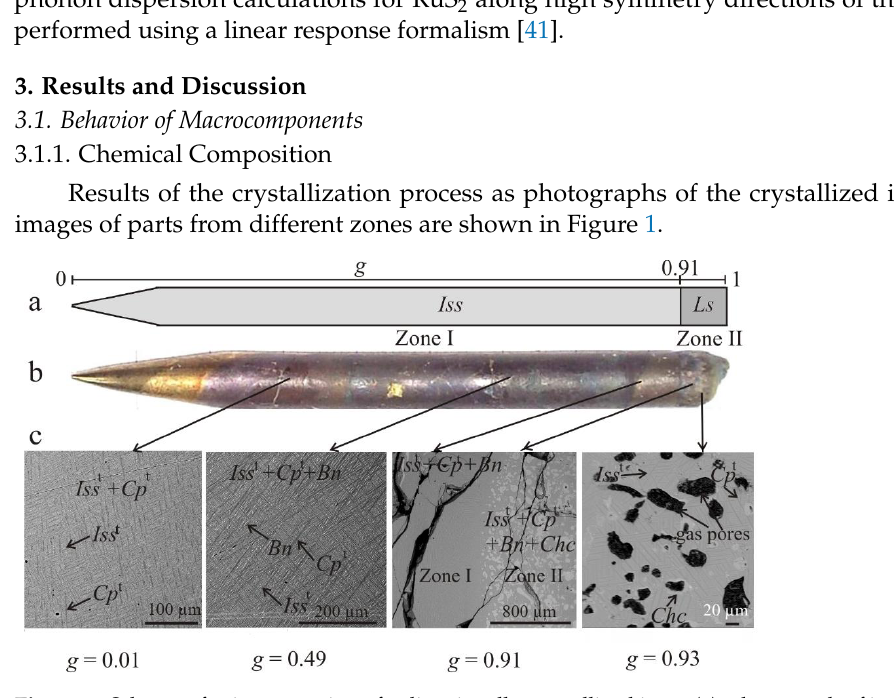
Figure 1. Scheme of primary zoning of a directionally crystallized ingot ( a ), photograph of ingot ( b ), and back-scattered electron images of sulfides in the secondary zones ( c ). Black areas are cracks and pores.